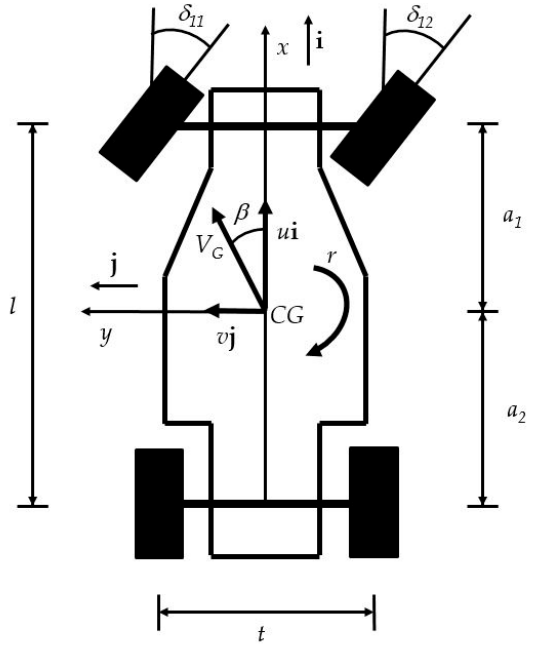
Figure 1. Kinematic modelling of a vehicle [113].